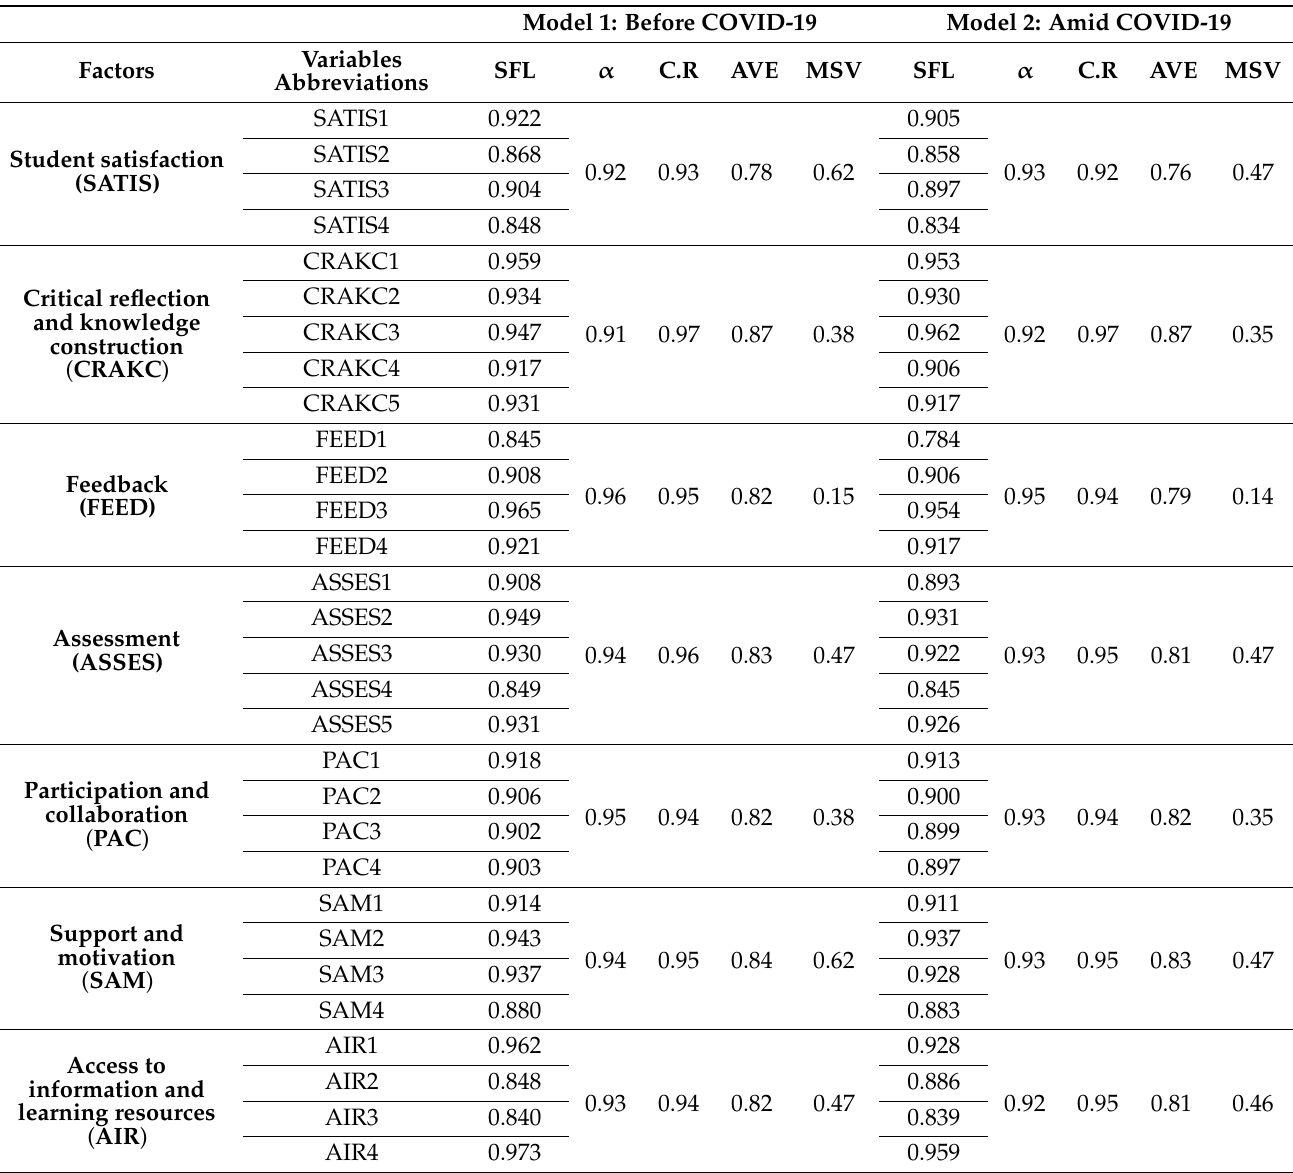
Table 1. Psychometric properties of the two tested